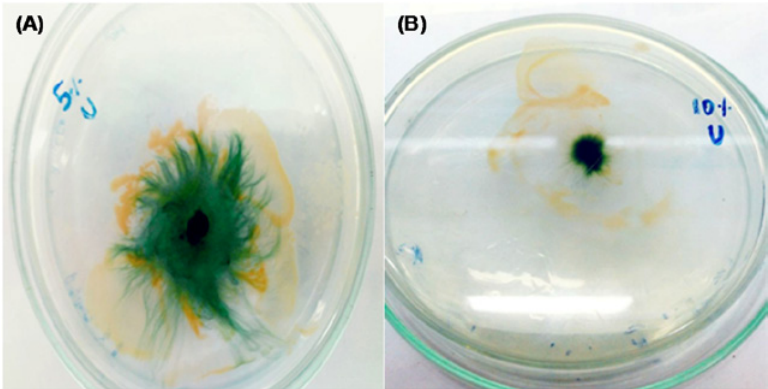
Fig. 2: Growth (10days) of Oscillatoria sp., (SRA) in agar medium containing varied dilution of cattle urine (A; 5%, B; 10%)